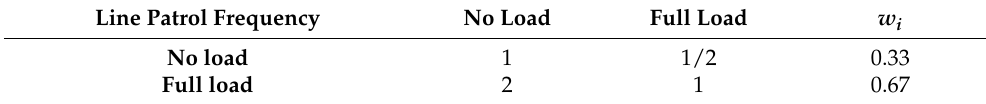
Table 18. Important judgment matrix of patrol frequency under different operating conditions.